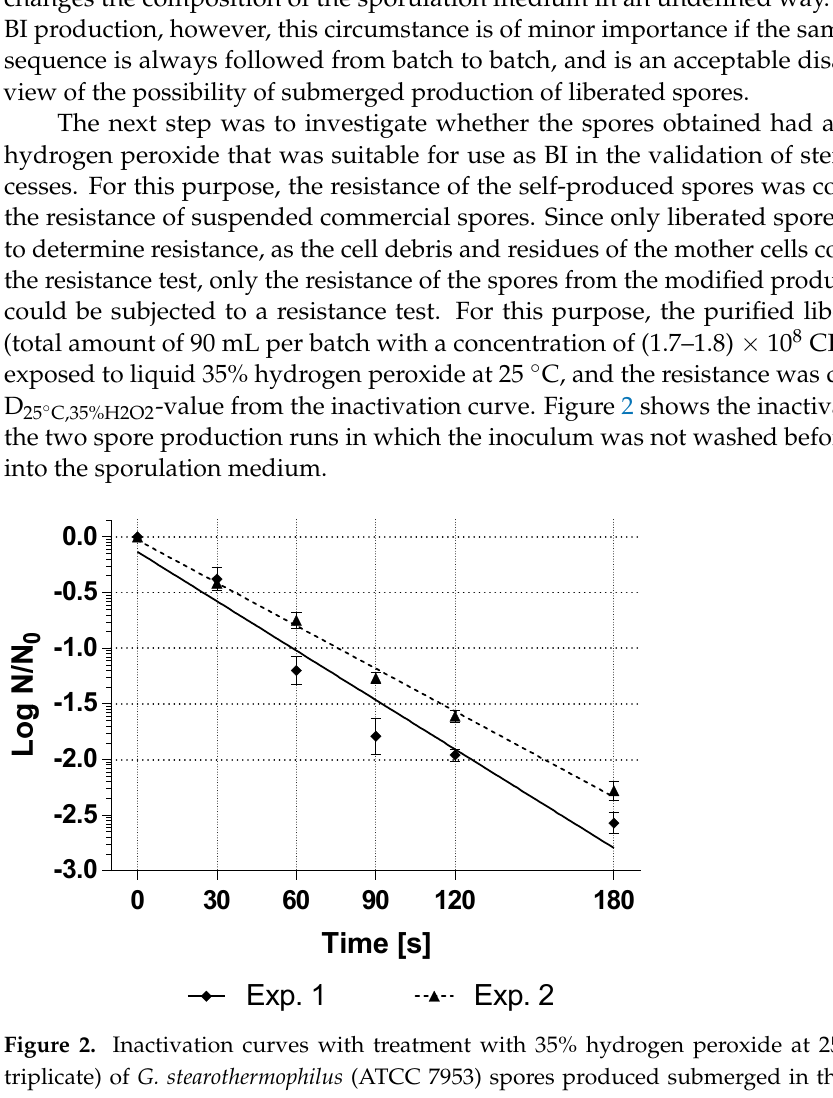
shows the inactivation curves of both BI as an average of the technical